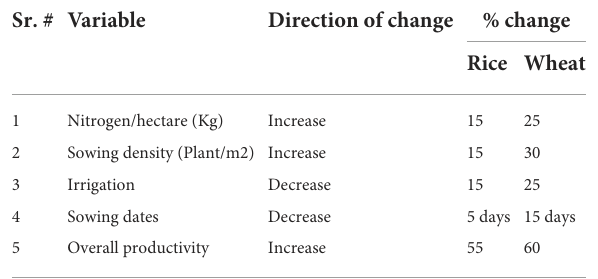
TABLE 5 Adaptation technology related to socioeconomic used for crop models (DSSAT and APSIM) to cope with the negative impacts of climate change during mid-century